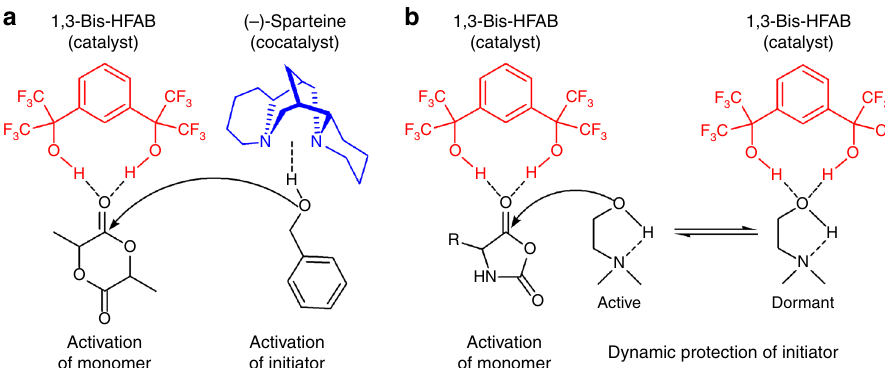
Fig. 1 Two different fl uorinated alcohol based organocatalytic systems for ROP. a the bicomponent-bifunctional fl uorinated alcohol/( − )-sparteine catalytic system for ROP of cyclic esters in which cocatalyst base, ( − )-sparteine, is required. b the concept of monocomponent-multifunctional fl uorinated alcohol catalytic system to be developed for ROP of NCA in this